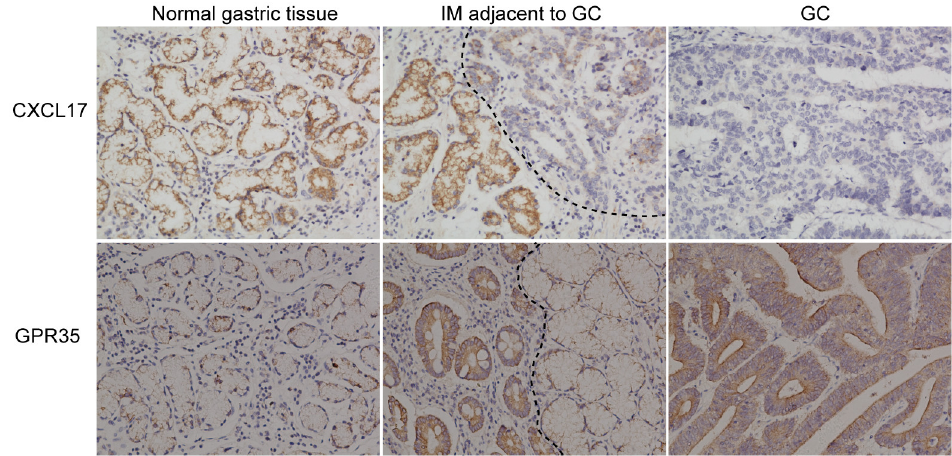
Figure 2. Representative immunostaining pictures of GC and adjacent non-tumor tissue (the distal normal gastric tissue and the IM adjacent to GC) from the same patient.